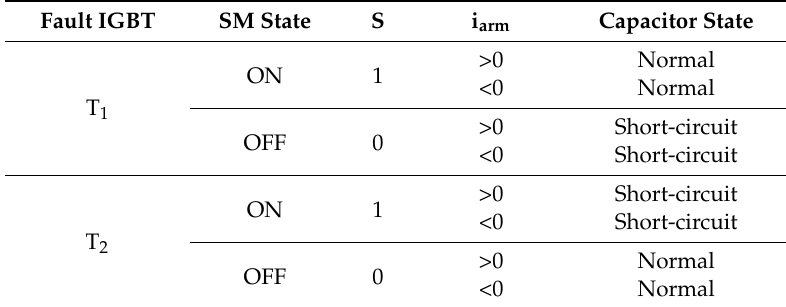
Table 2. State of the capacitor under different IGBTs short-circuit faults.